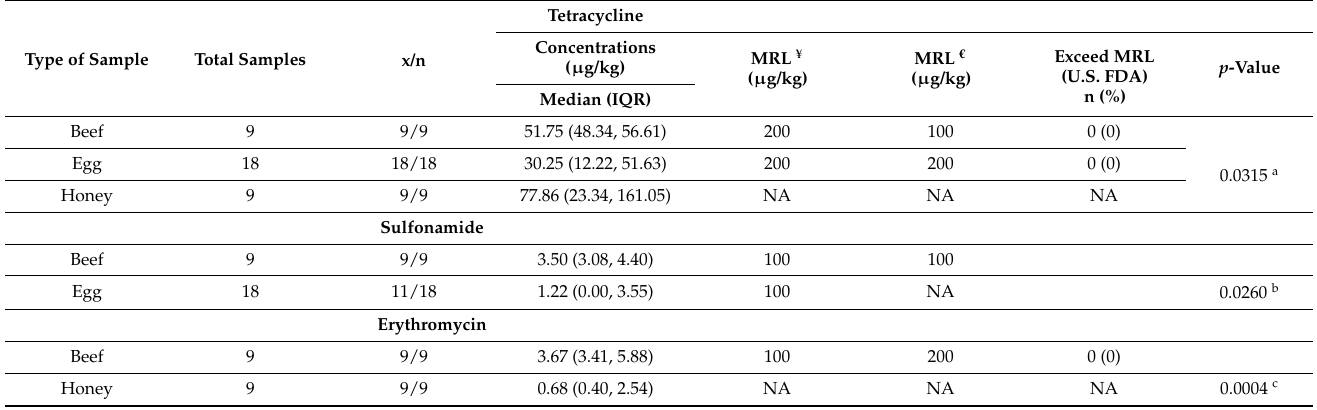
Table 1. Tetracycline, sulfonamide, and erythromycin residues in foods of animal origin sold in farmers’ markets in East Tennessee (USA) during summer